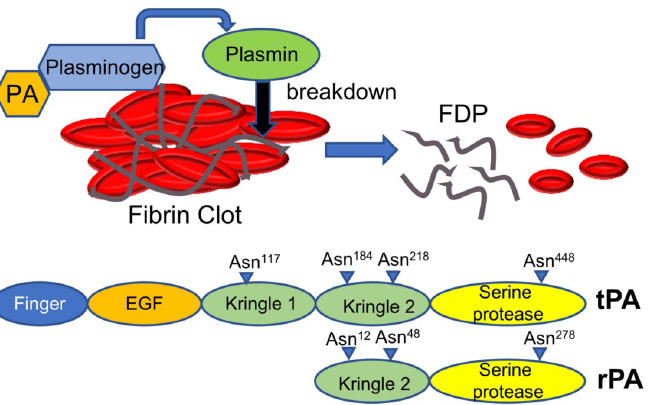
Fig 1. Schematic representation of tissue plasminogen activators (PA) mode of action and functional domains. Plasminogen activators cleave the zymogen plasminogen to form the serine protease, plasmin. The fibrinolytic enzyme plasmin breaks the cross-links between fibrin molecules, which are the structural support of the blood clot generating fibrin degradation products (FDP). Alteplase (tPA) has 5 domains: A finger domain, an epidermal growth factor (EGF)-like domain, 2 kringle domains, and a serine protease proteolytic domain. Reteplase (rPA) is a deletion of tPA consisting in only the kringle 2 domain and the serine protease proteolytic domain. Protein glycosylation sites are